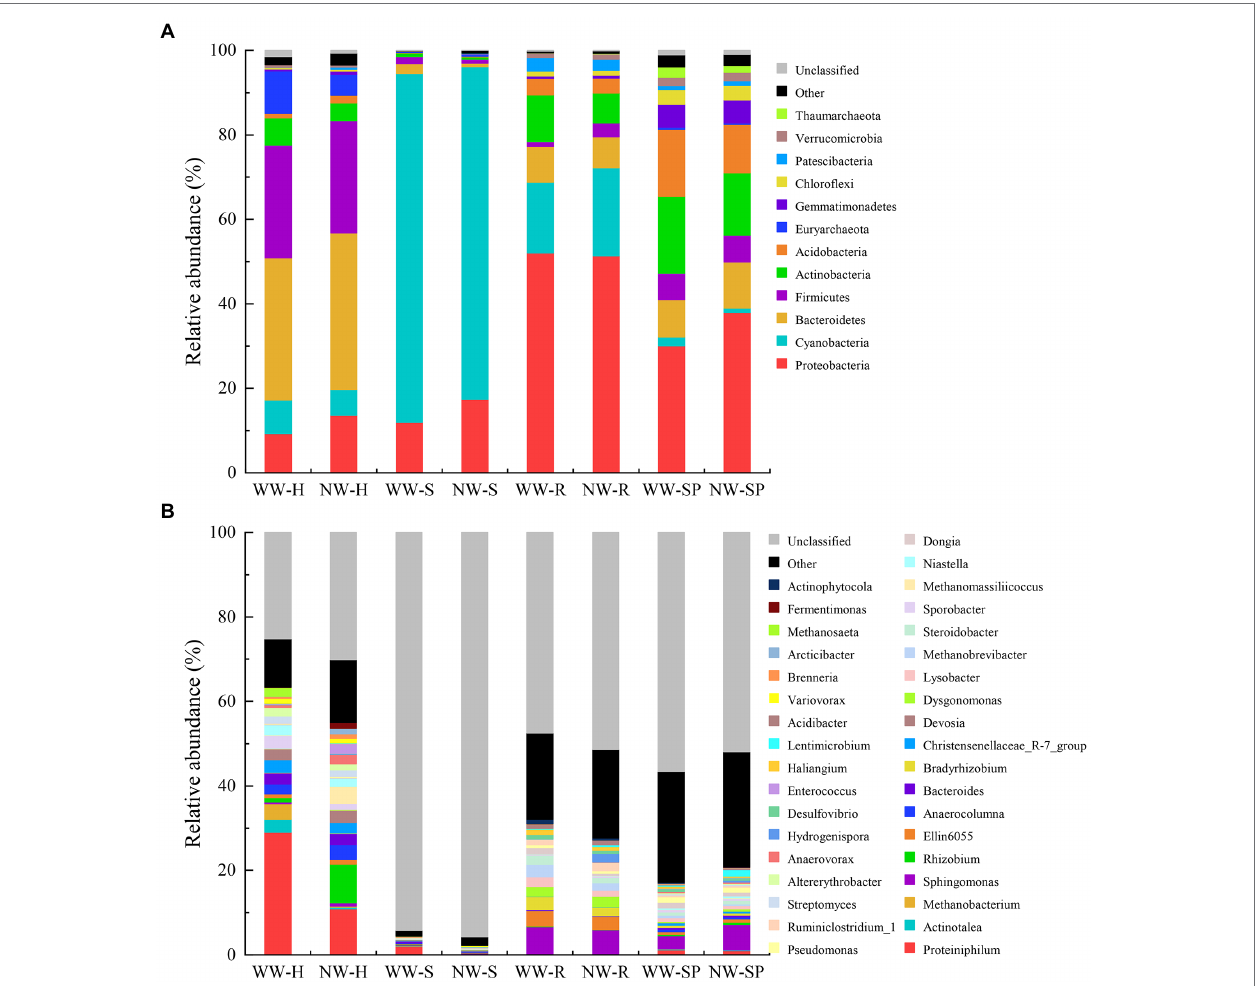
FIGURE 7 | Relative abundance of species in the samples. (A) Relative abundance of bacterial taxa at the phylum level; (B) Relative abundance of bacterial taxa at the genus level. The figure shows species with relative abundance >1% of each group at each taxonomic level. WW-H, NW-H, WW-S, NW-S, WW-R, NW-R, WW- SP, and NW-SP represent heartwood of diseased trees, heartwood of healthy trees, sapwood of diseased trees, sapwood of healthy trees, root of diseased trees, root of healthy trees, rhizosphere soil of diseased trees, and rhizosphere soil of healthy trees,